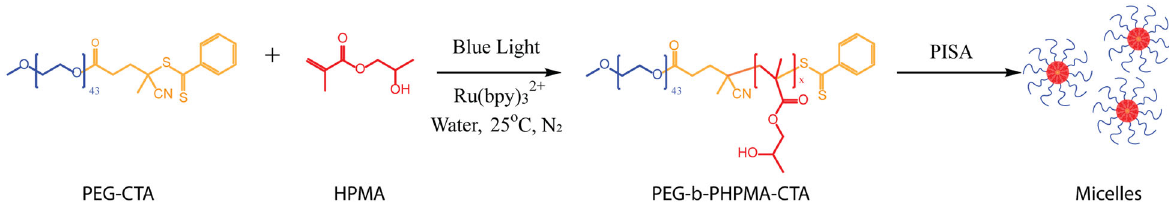
Fig. 1 Light-mediated polymerization-induced self-assembly. Synthesis route for preparation of micelles via PET-RAFT PISA reaction using PEG-CTA and HPMA catalyzed by Ru(bpy) 3 2 + under blue light irradiation in an